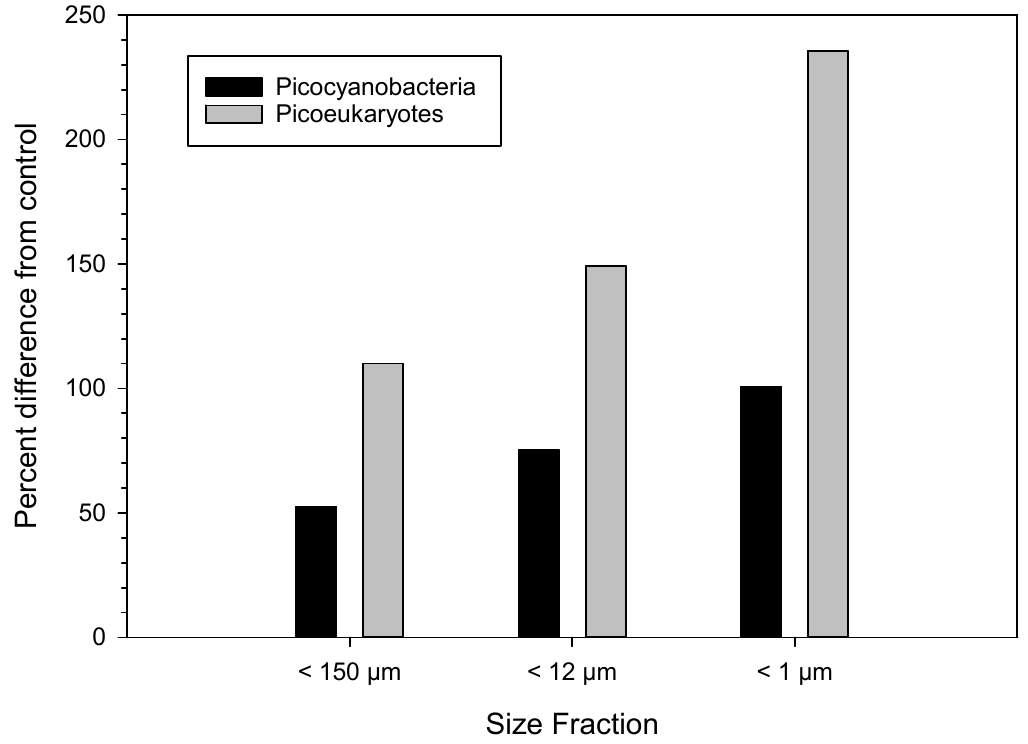
Figure 5. Growth of picocyanobacteria and picoeukaryote algae in different size-fractionated water samples during a three-day bioassay. Station 3 water samples, collected on 2 October 2009 during a picoplankton bloom, were amended with 1 µM urea additions.